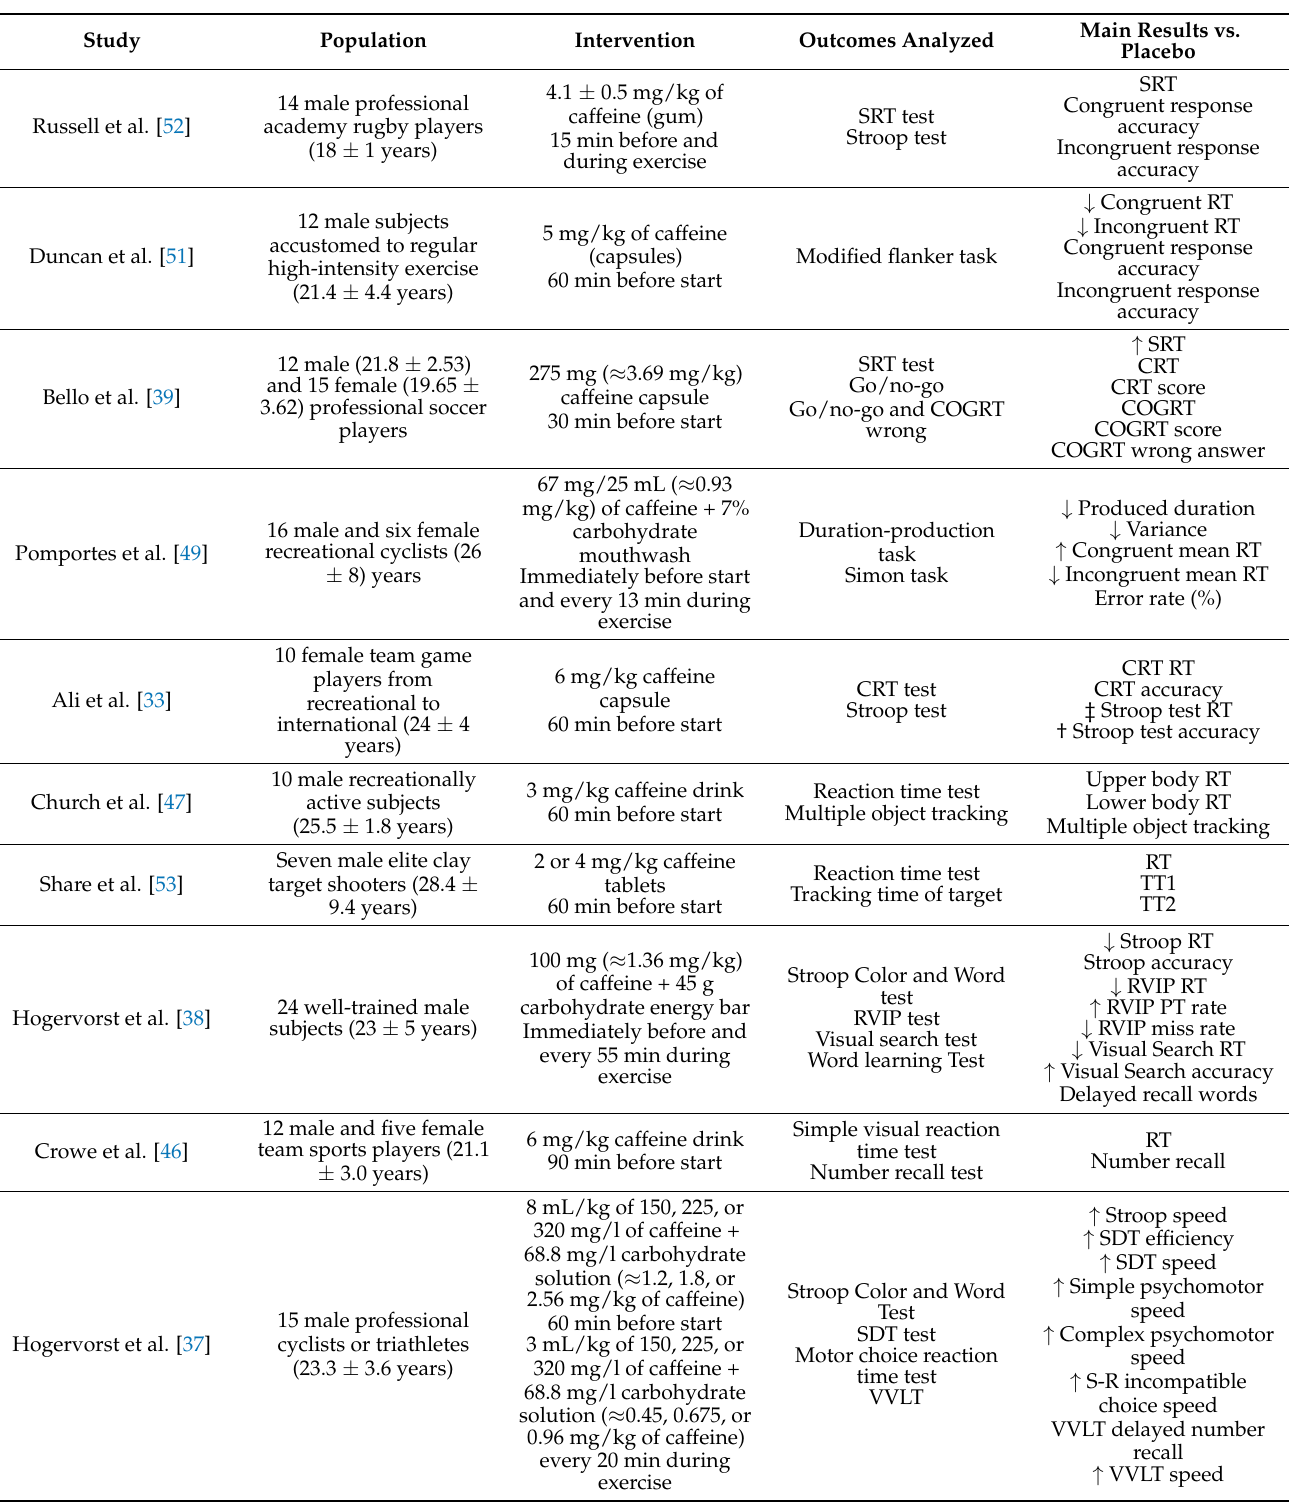
Table 5. Details and results of the studies reviewed investigating the effect of acute caffeine supplementation compared to a placebo on objective measures of cognitive